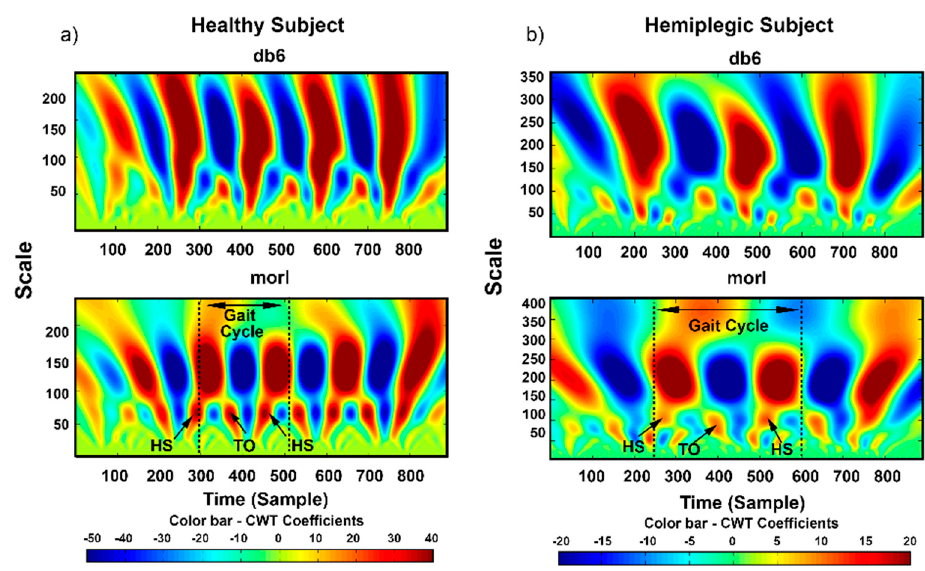
Figure 3. Continuous wavelet transform (CWT) plots of the acceleration signals during walking from one healthy subject ( a ) and one hemiplegic subject ( b ), where two mother wavelets (“db6” and “morl”) were adopted for comparison. The underlying scale relationship between the gait events (HS and TO) and gait cycles are illustrated.